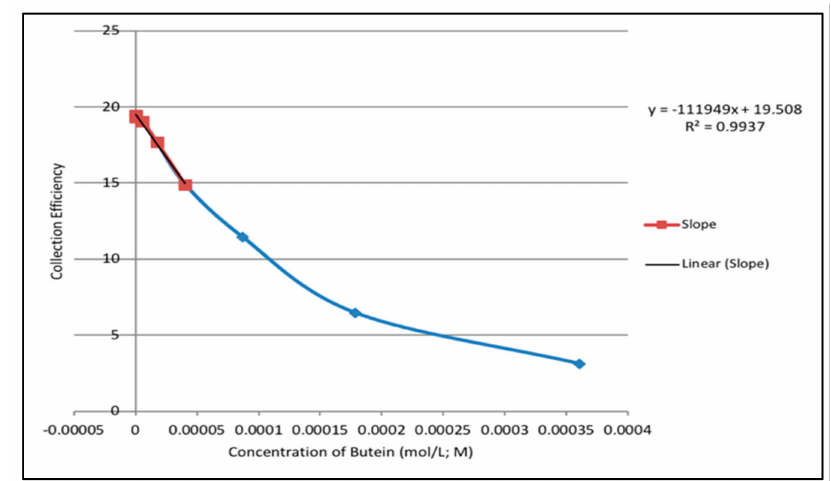
Figure 32. Collection efficiency for